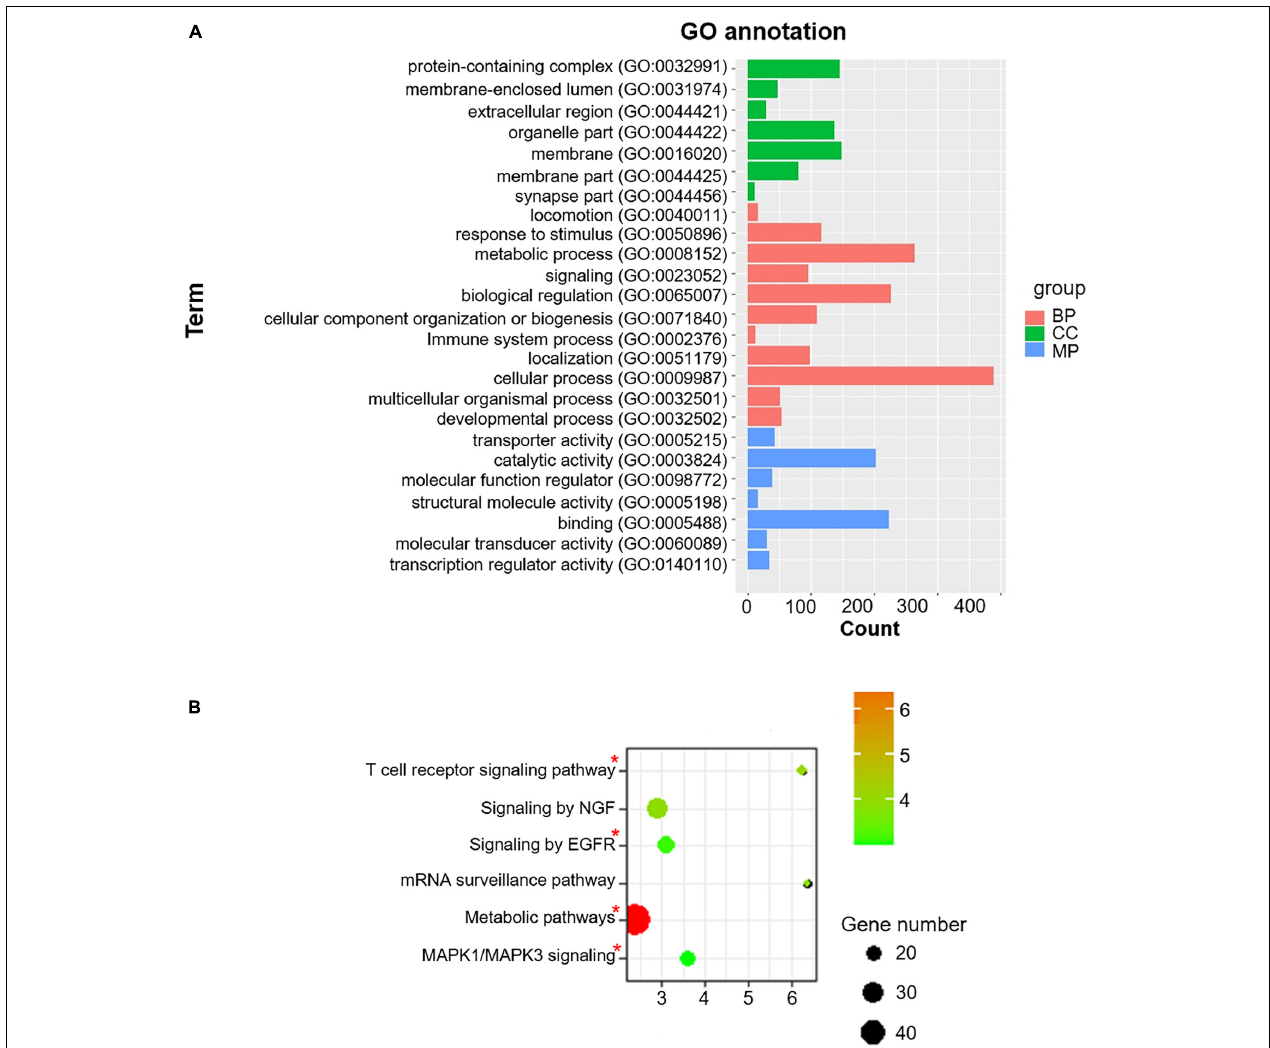
FIGURE 3 | Co-m 6 AR GO functional classification and pathway enrichment analysis. (A) Gene-ontology (GO) functional classification. GO analyses of differently expressed genes in control versus T2DM islet β -cells. (B) Kyoto Encylopedia of Genes and Genomes (KEGG) pathway enrichment. KEGG analyses of 985 identified m 6 A-associated genes in control versus T2DM islet β -cells. The pathway involved in T2DM development was marked with red